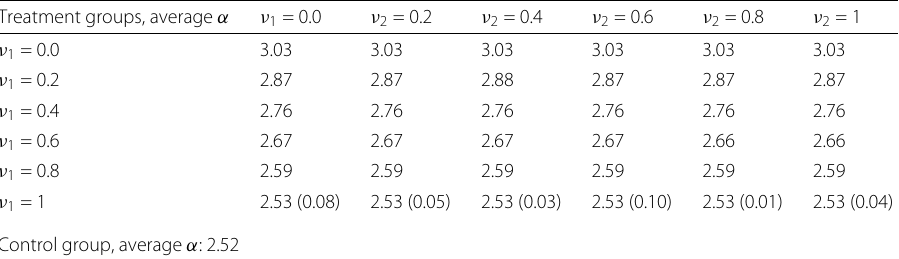
Table 8 Average values of the power-law model’s exponent α in the control group and in the treatment group by values of ν 1 and ν 2 , computed over k > 1 Treatment groups, average α ν 1 = 0.0 ν 2 = 0.2 ν 2 = 0.4 ν 2 = 0.6 ν 2 = 0.8 ν 2 = 1 ν 1 = 0.0 ν 1 = 0.2 ν 1 = 0.4 ν 1 = 0.6 ν 1 = 0.8 ν 1 = 1